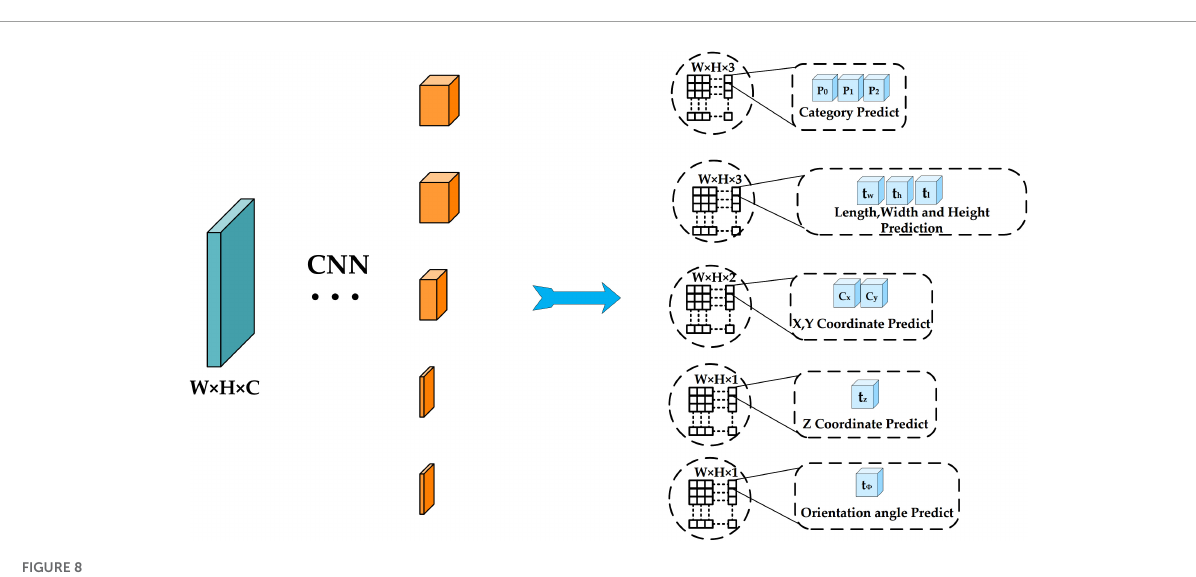
FIGURE8 Improve head network